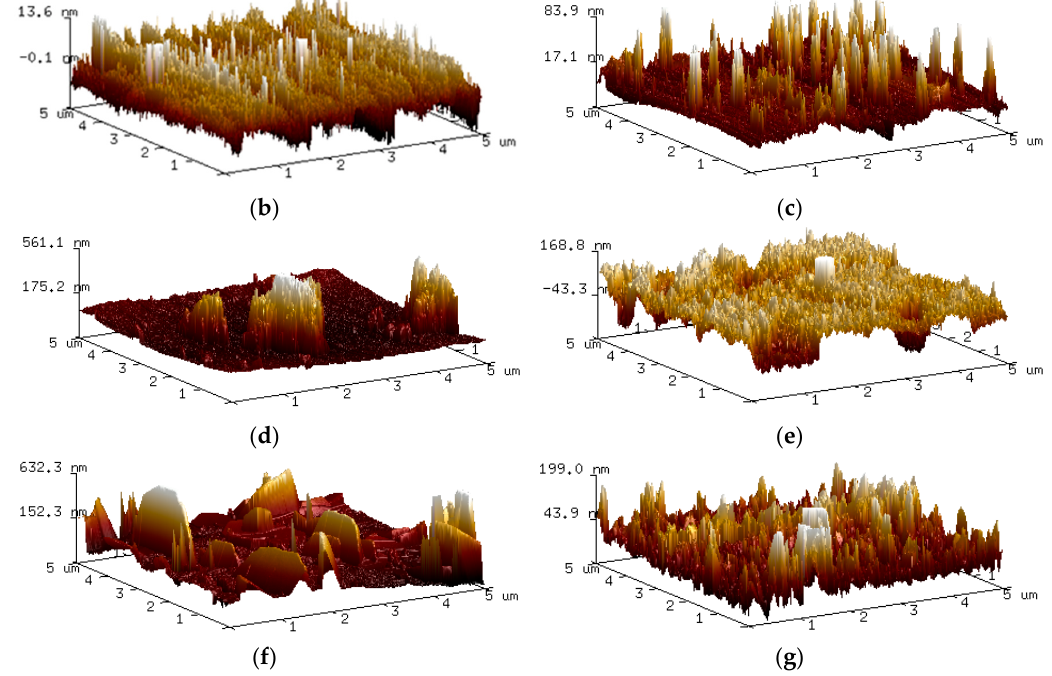
Figure 5. Three-dimensional AFM topographic imaging of the steel surface after ( a ) 0 h, ( b ) 1 h, ( c ) 2 h,